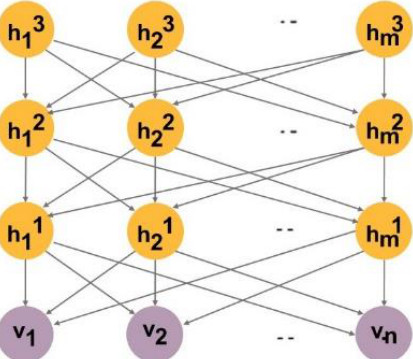
Figure 4. Schematic of a deep belief network. Source: Sezer et al. [14].